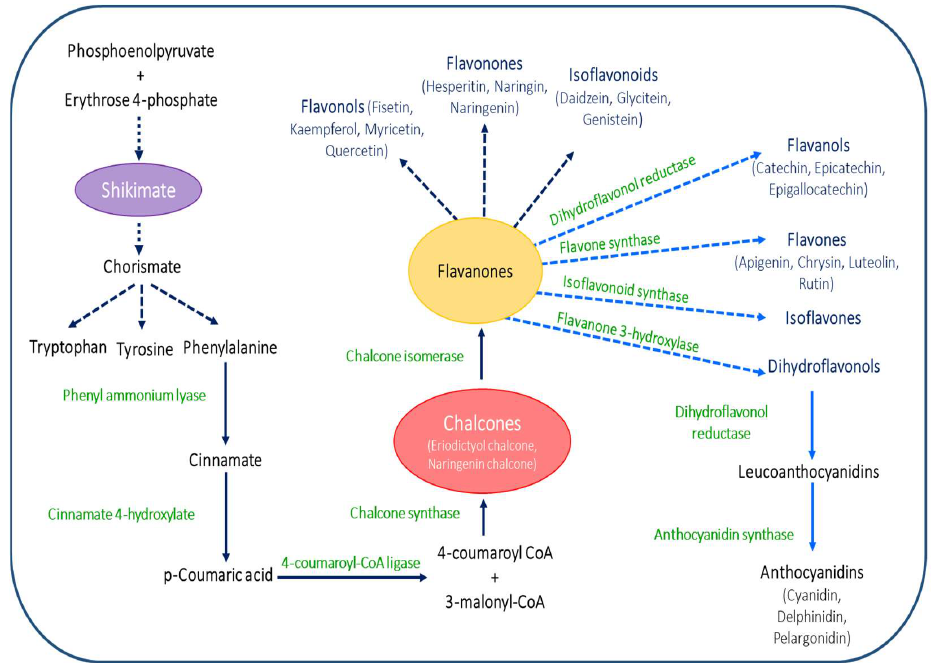
Figure 1. Biochemistry of flavonoids with their various subgroups: Phosphoenolpyruvate and erythrose-4-phosphate are converted to chorismate via the shikimate pathway in seven metabolic stages. Chorismate is the common precursor of three aromatic amino acids viz., tryptophan, tyrosine, and phenylalanine. The enzyme phenyl ammonium lyase (PAL) induces the synthesis of cinnamic acid from phenylalanine, and cinnamate is converted to p-Coumaric acid by the activity of cinnamate 4-hydroxylate. Another enzyme 4-coumaroyl CoA ligase converts p-Coumaric acid into 4-coumaroyl CoA and 3-malonyl CoA, which are responsible for synthesizing chalcones by chalcone synthase activity. Eriodictyol chalcone and naringenin chalcone are the two classes of chalcones. The flavanones are synthesized from chalcones by the activity of chalcone isomerase. There are different subgroups of flavonoids, shown in this diagrammatic representation. Fisetin, kaempferol, myricetin, and quercetin are the types of flavonols. Hesperitin, naringin, and naringenin are the types of flavanones. Some types of isoflavonoids are daidzein, glycitein, and genistein. Flavanols are produced from flavanones by dihydroflavonol reductase activity, and some examples of flavanols are catechin, epicatechin, and epigallocatechin. The enzyme flavone synthase is responsible for the production of flavones from flavanones. Apigenin, chrysin, luteolin, and rutin are some types of flavones. The two other flavonoid subgroups—isoflavones and dihydroflavonols—are synthesized by the activity of isoflavonoid synthase and flavanone 3-hydroxylase, respectively. Dihydroflavonol reductase converts dihydroflavonols into leucoanthocyanidins, which are converted into anthocyanidins by the anthocyanidin synthase enzyme. Cyanidin, delphinidin, and pelargonidin are some types of anthocyanidins.